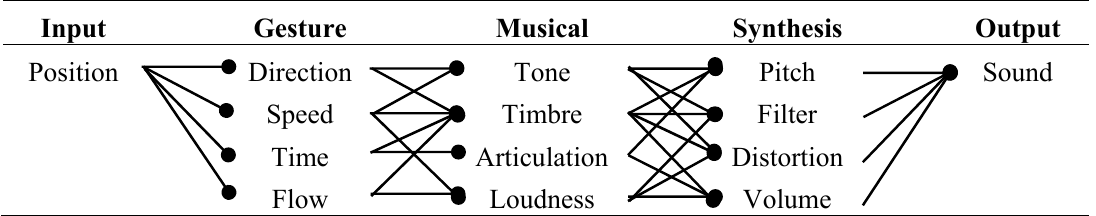
Table 2. Example complex